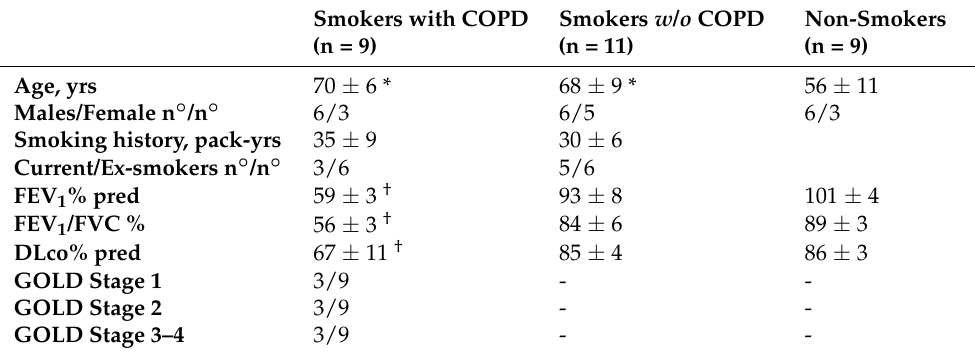
Table 1. Clinical characteristics of the subjects in the study.